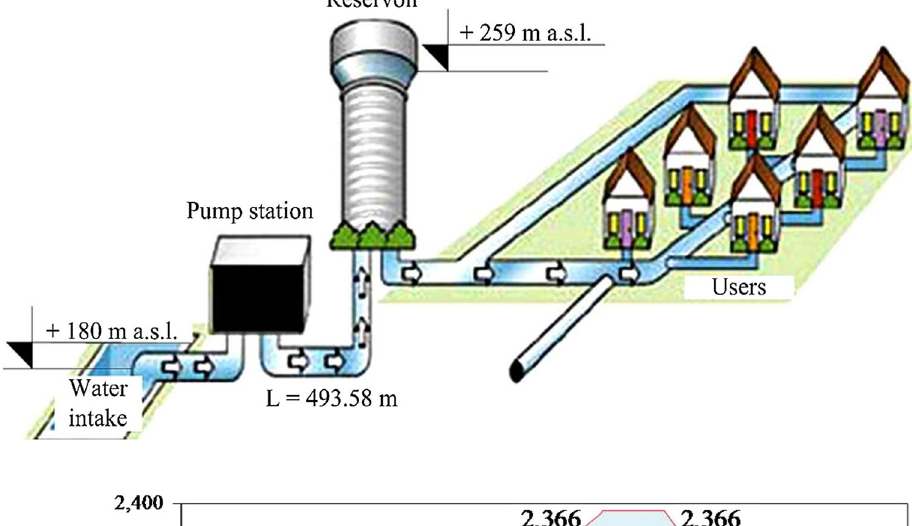
Fig. 4 Daily water demand